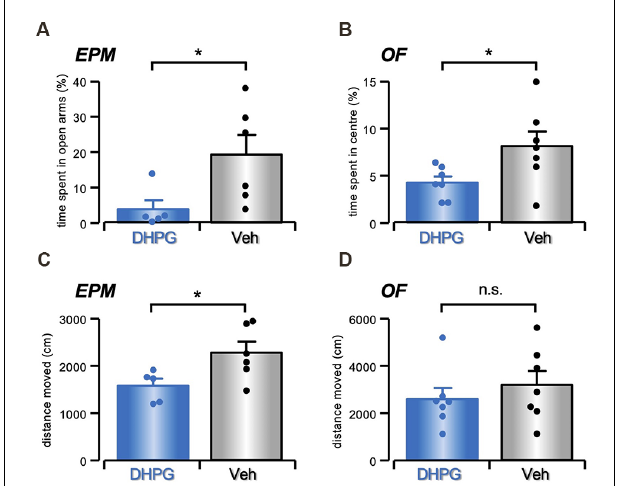
FIGURE 6 | Anxiety-like behavior in DHPG-infused mice. (A) Histogram with single data points showing in % (mean ± s.e.m.) the time spent in the open arms of Elevated Plus Maze by DHPG (50 µ M in NaCl 0.9%, n = 5) or Veh (NaCl 0.9%, n = 6) treated mice (* P < 0.05, Student’s t-test). (B) Histogram with single data points showing in % (mean ± s.e.m.) the time spent in the center of Open Field by DHPG- ( n = 7) and Veh-treated ( n = 7) mice (* P < 0.05, Student’s t-test). (C) Histogram with single data points showing in % (mean ± s.e.m.) the locomotor activity measured as total distance traveled (cm) over the arms in Elevated Plus Maze in DHPG- ( n = 5) and Veh-treated ( n = 6) mice (* P < 0.05, Student’s t-test). (D) Histogram with single data points showing in % (mean ± s.e.m.) the locomotor activity measured as total distance traveled (cm) over the Open Field in DHPG- ( n = 7) and Veh-treated ( n = 7) mice (n.s. P > 0.05, Student’s t-test). DHPG-treated and Veh-treated mice ( t = 1.37, P = n.s.,